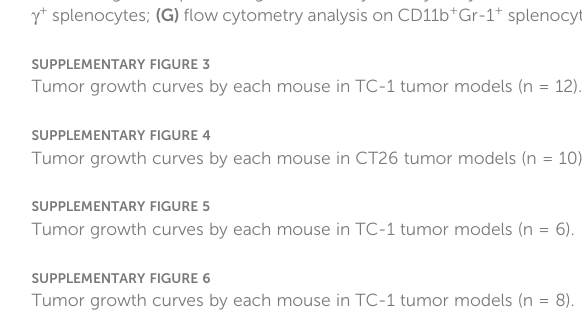
SUPPLEMENTARY FIGURE 3 Tumor growth curves by each mouse in TC-1 tumor models (n = 12). SUPPLEMENTARY FIGURE 4 Tumor growth curves by each mouse in CT26 tumor models (n = 10). SUPPLEMENTARY FIGURE 5 Tumor growth curves by each mouse in TC-1 tumor models (n = 6). SUPPLEMENTARY FIGURE 6 Tumor growth curves by each mouse in TC-1 tumor models (n =